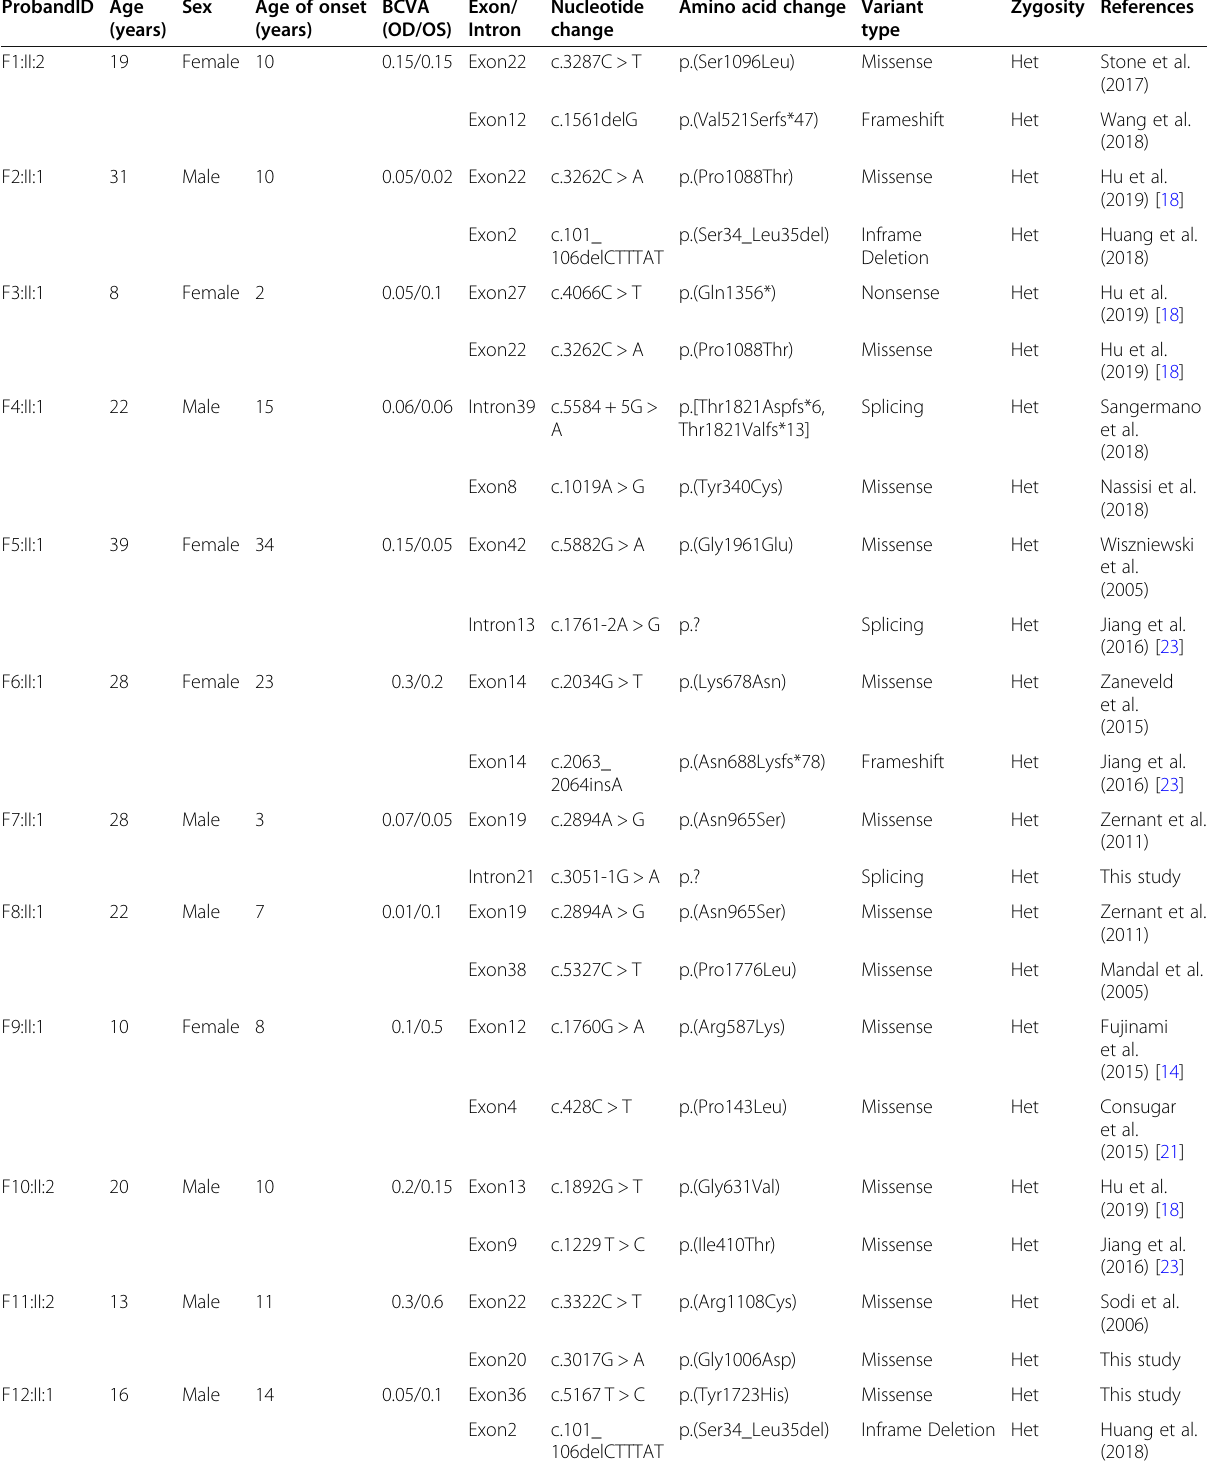
Table 1 The ABCA4 disease-associated variants identified in this study ProbandID Age (years)